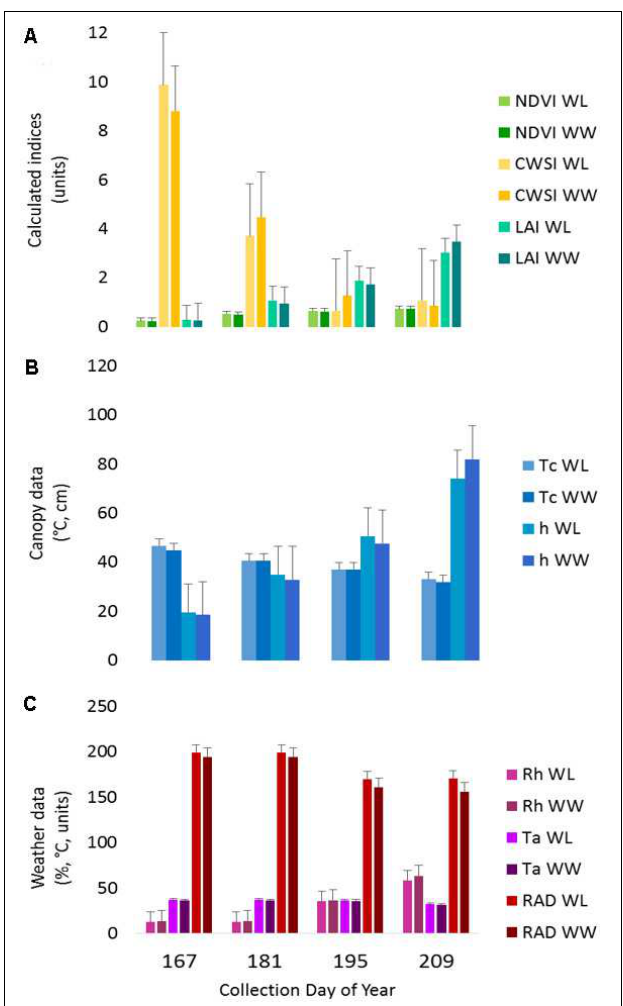
FIGURE 3 | Proximal sensing carts (PSC)-derived phenotypes split out by irrigation treatment for each collection day. The data represent the average of each phenotype for the designated treatment and day of year. (A) The normalized difference vegetative index (NDVI), crop water stress index (CWSI), and leaf area index (LAI) data are presented as calculated index units with corresponding error bars. (B) The canopy temperature ( Tc ) and canopy height ( h ) with the corresponding error bars. (C) The weather data presented in each respective unit of measurement for ambient air temperature ( Ta ), relative humidity ( Rh ), and radiant energy (RAD) with corresponding error